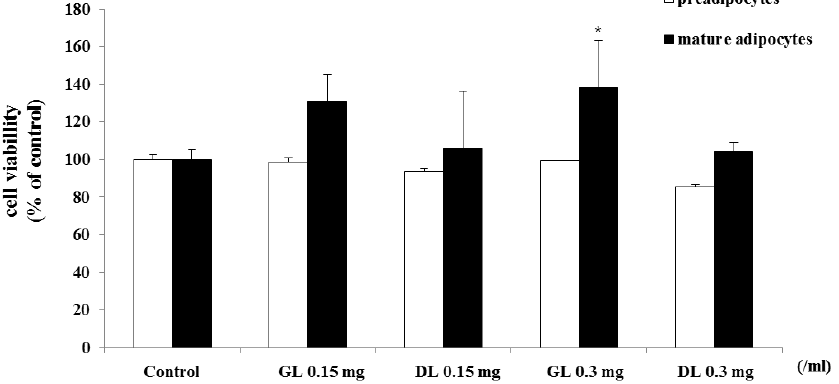
Figure 4. Effects of GL and DL on cell viability of 3T3-L1 preadipocytes and mature adipocytes. 3T3-L1 preadipocytes were treated with GL or DL for 48 h, or left untreated. 3T3-L1 preadipocytes were differentiated into adipocytes and treated with GL or DL for the entire differentiation period or after induction of differentiation. Cell viability was evaluated by using the MTT assay and the absorbance was measured at 495 nm. * p < 0.05. Bars represent means ± SD from three independent experiments.